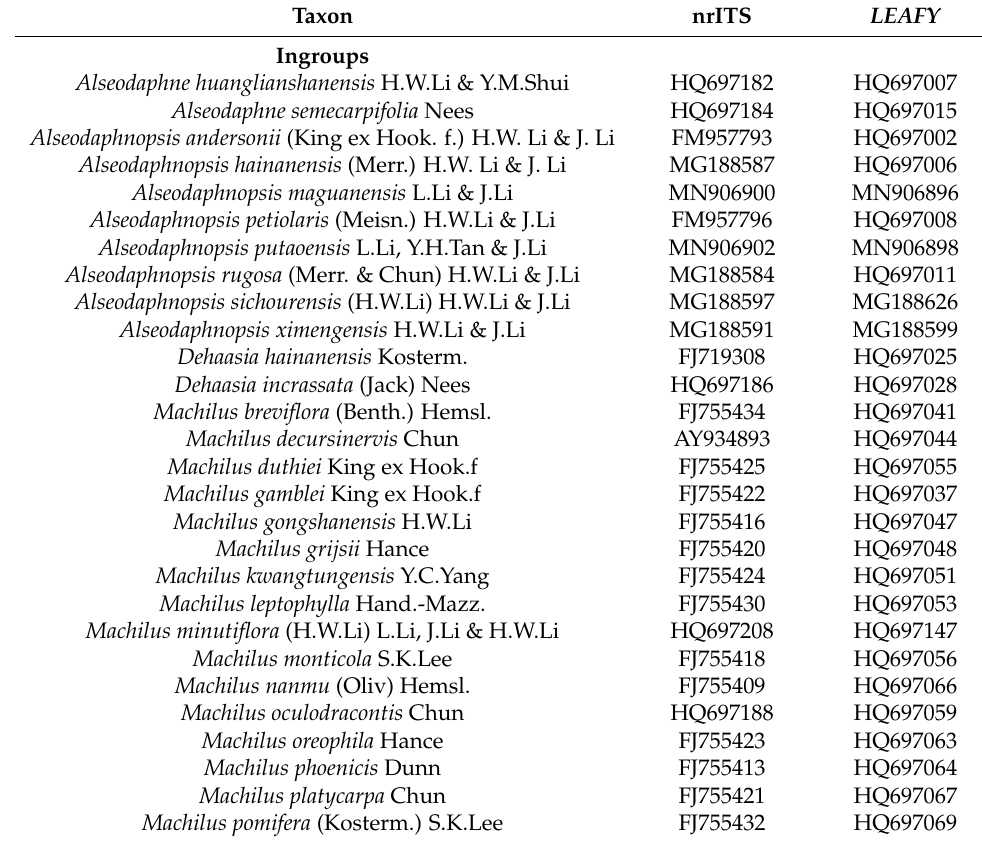
Table 1. GenBank accession numbers for nrITS and LEAFY sequences. Taxon nrITS